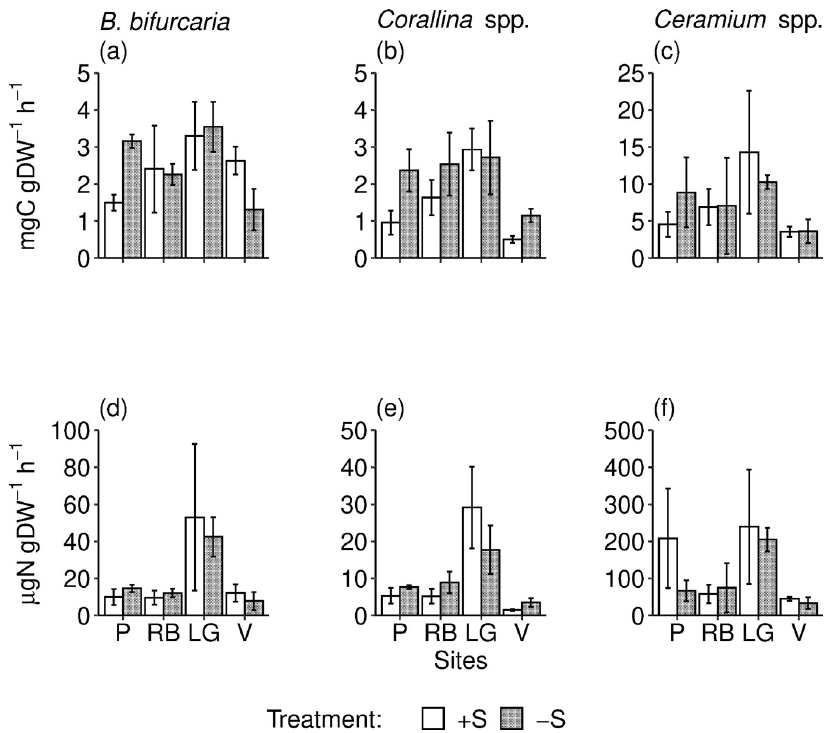
Fig 2. Estimates of macroalgal physiological traits. Mean (SE) gross primary production (a-c) and nitrogen uptake rate (d-f) of the 3 dominant native macroalgae in S . muticum— removed (-S) and control rock pools (+S) at each site (P, RB, LG, V, as indicated in Fig 1 legend).